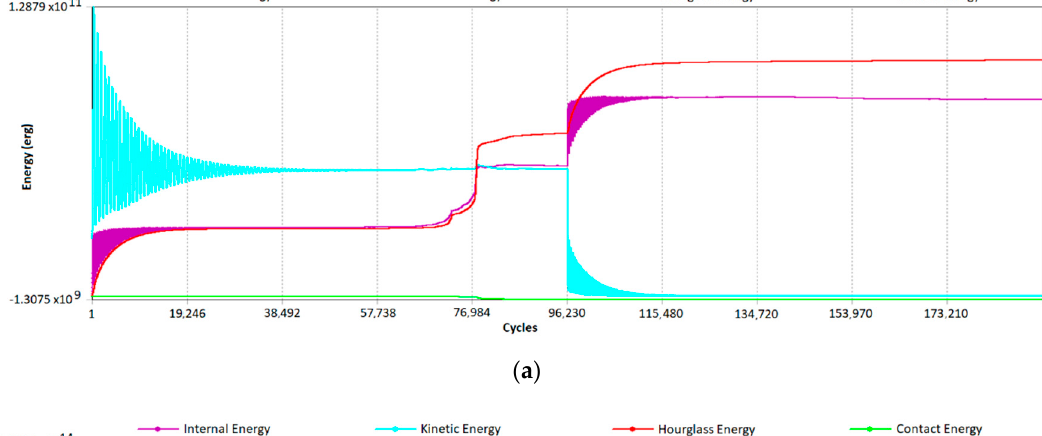
Figure 12. View showing the hourglass effect.